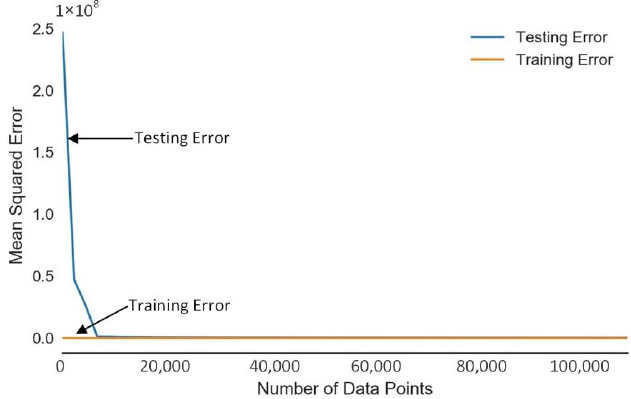
Figure 9 . Learning curve for extra trees regressor. Figure 9. Learning curve for extra trees